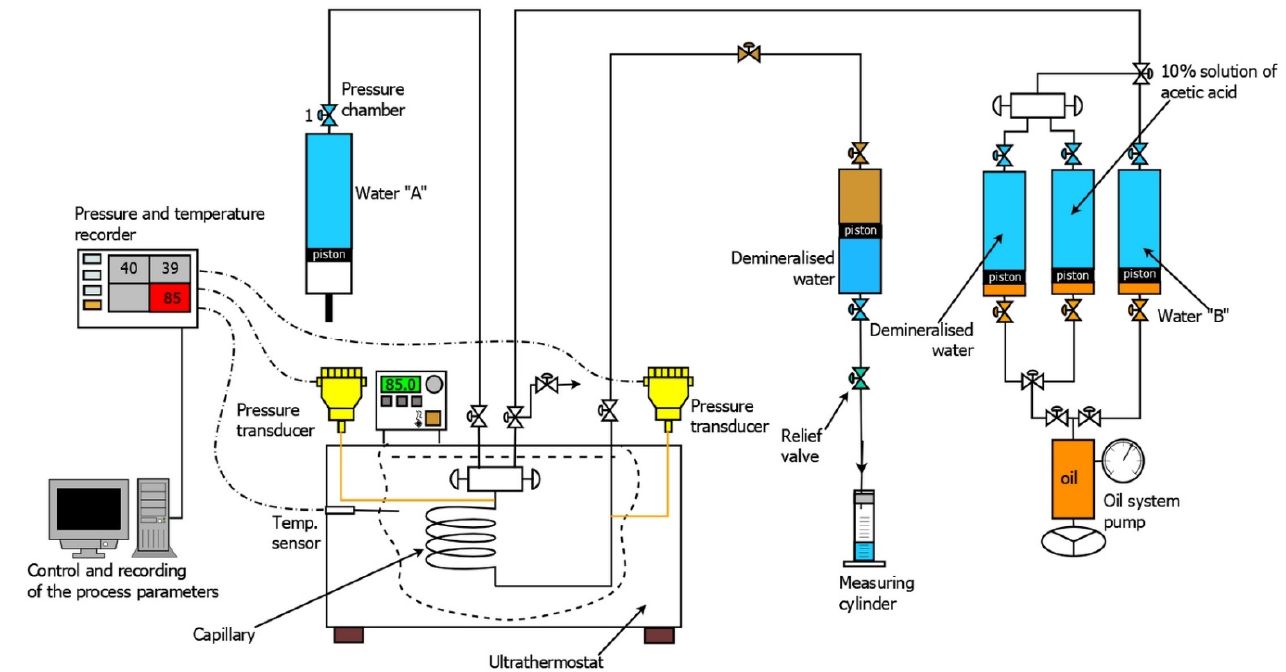
Figure 1. Measuring system